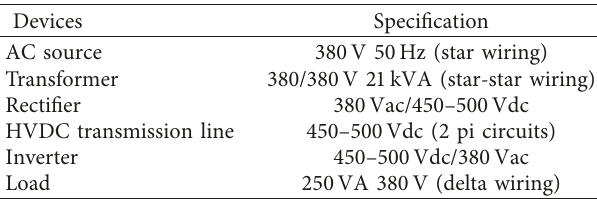
Table 3: Specification of the designed